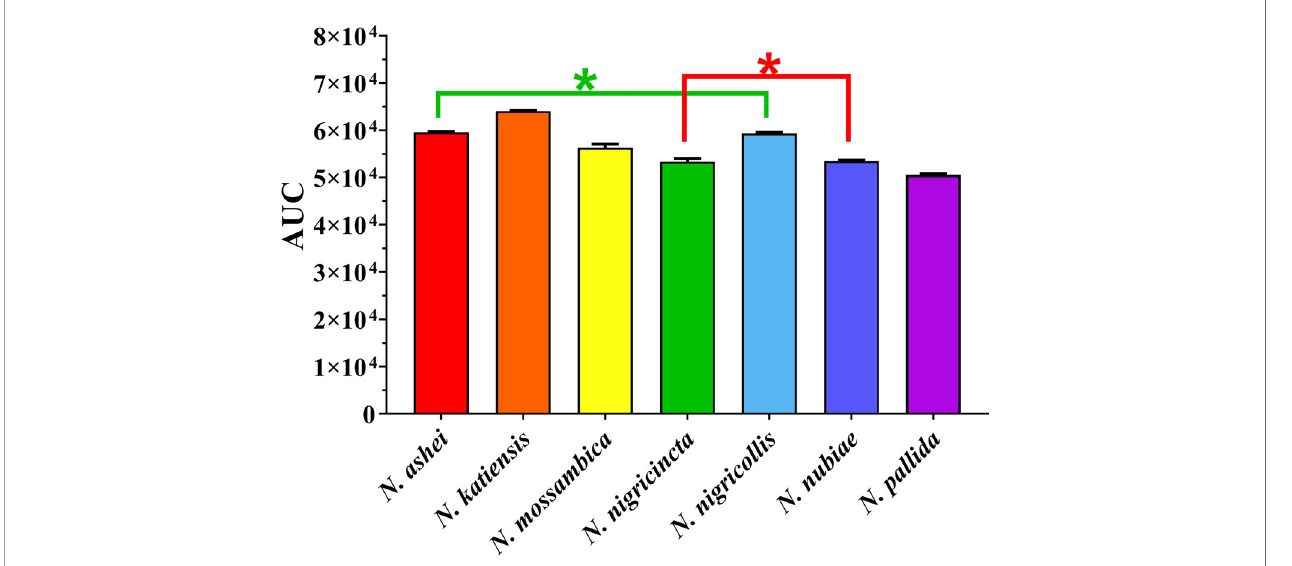
FIGURE 1 | Y-axis showing area under the curve (AUC) of clotting times on human plasma produced through inhibition of FXa by African spitting Naja venoms (x- axis). Higher AUC indicated higher anticoagulant activity. *Represents no statistical signi fi cance AUC ( p > 0.05) in Tukey ’ s multiple comparisons test at 95.00 % con fi dence